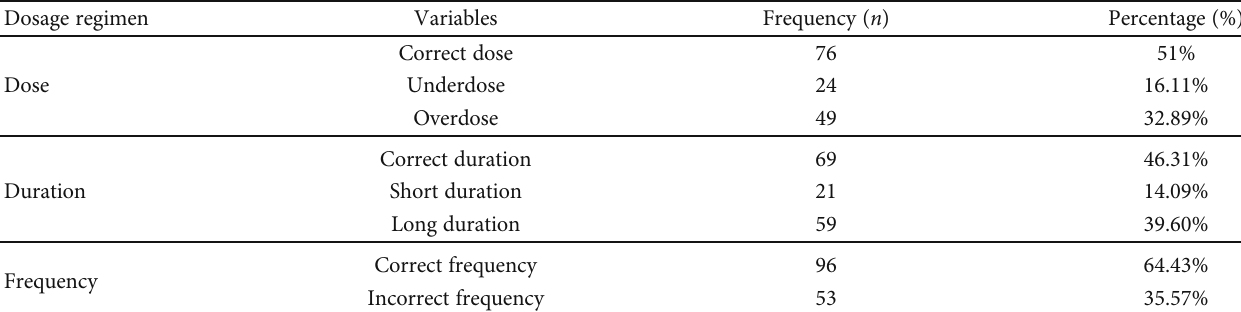
Table 4: Dosage regimens of beta-blockers used in the medical wards of NGH within 2 years. Dosage